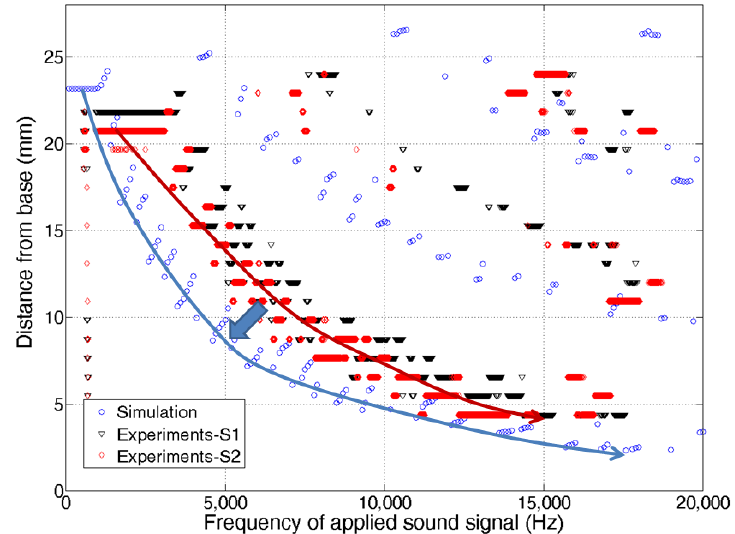
Figure 9. Frequency separation of the McPAS device under mechanical